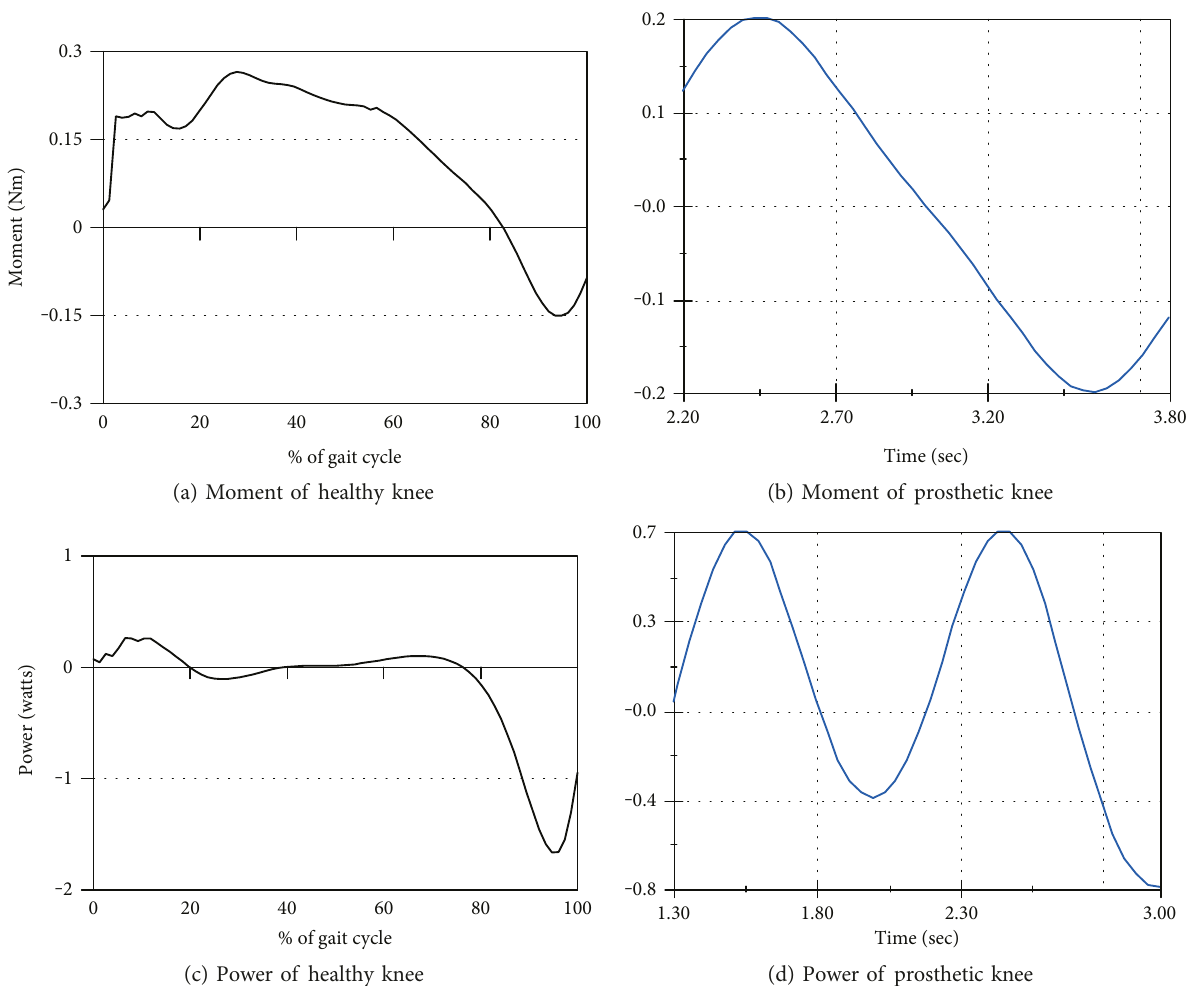
Figure 6: Joint moment and joint power of the knee joint obtained from a healthy subject and from motion analysis of the prosthetic